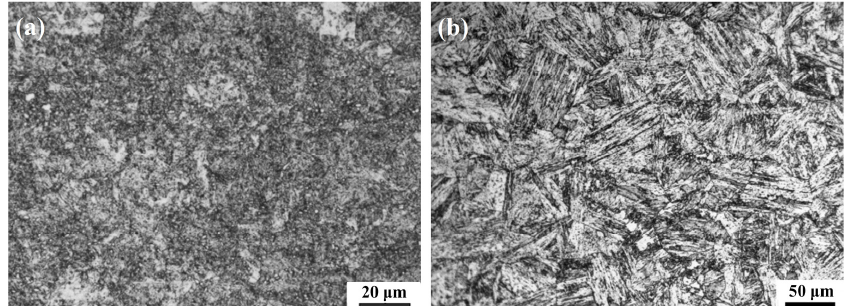
Figure 1. Microstructure of two materials: ( a ) 3Cr13 martensitic stainless steel tempered at 540 °C, ( b ) 00Cr12Ni10MoTi martensitic stainless steel aged at 510 °C.